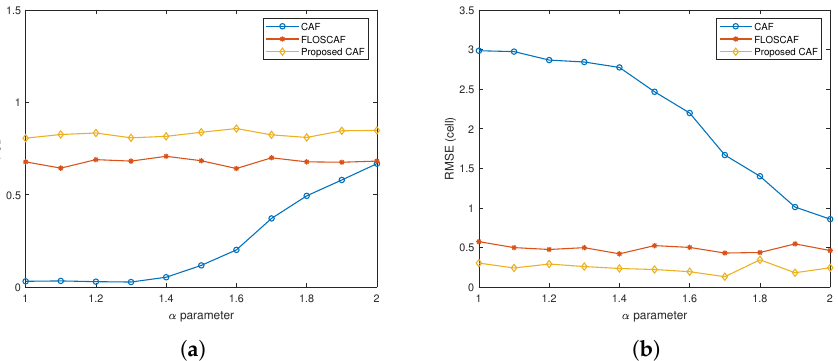
Figure 8. ( a ) Probability of Detection (PoD) comparison for different algorithms (RCS = 0.5 m 2 ) ( b ) Root Mean Square Error (RMSE) comparison for different algorithms (RCS = 0.5 m 2 ).